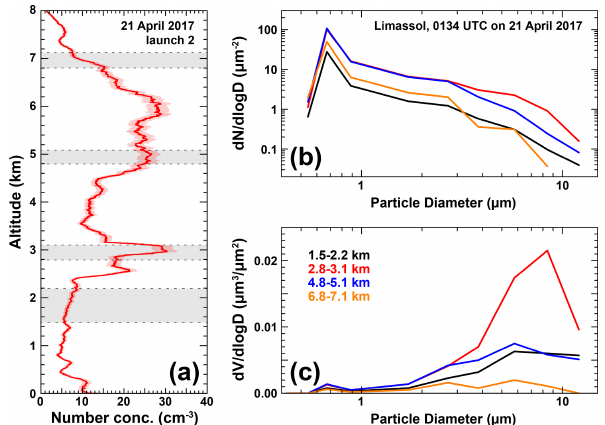
Figure 8. UCASS measurements during the second launch at 01:34UTC on 21 April 2017 from Limassol: (a) height profile of the total particle number concentration as in Fig. 4 and (b) parti- cle number and (c) volume–size distributions averaged over four selected height levels as indicated in (a)